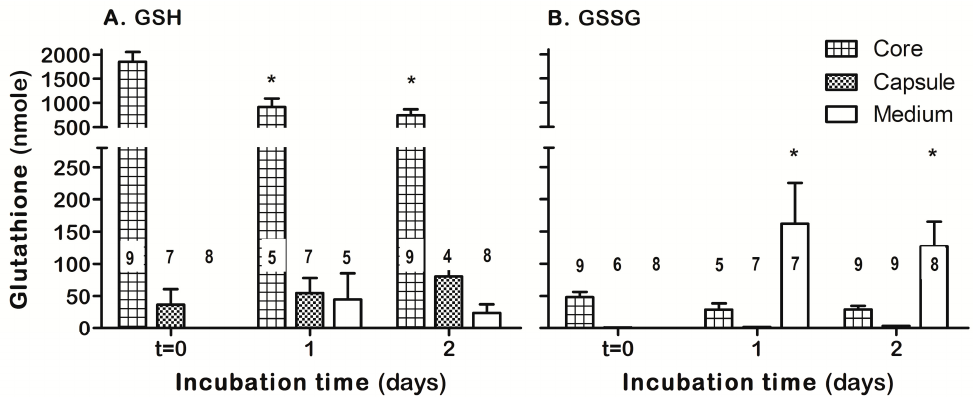
Figure 7. Time-dependent glutathione content in lens core and capsule. Fresh lenses ( t = 0) or those cultured for 1 or 2 days were collected for glutathione determination. Media were harvested and lenses core and capsule were separated. The level of GSH (A) and GSSG (B) in the core, capsule and medium were determined. The number of lenses per each treatment is indicated in each bar. Significant differences were marked: * p < 0.05 versus t = 0).